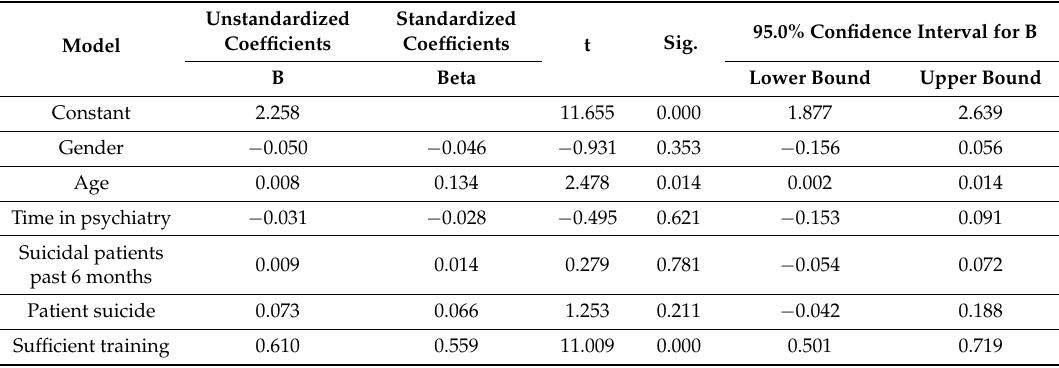
Table 3. Predictors for Job